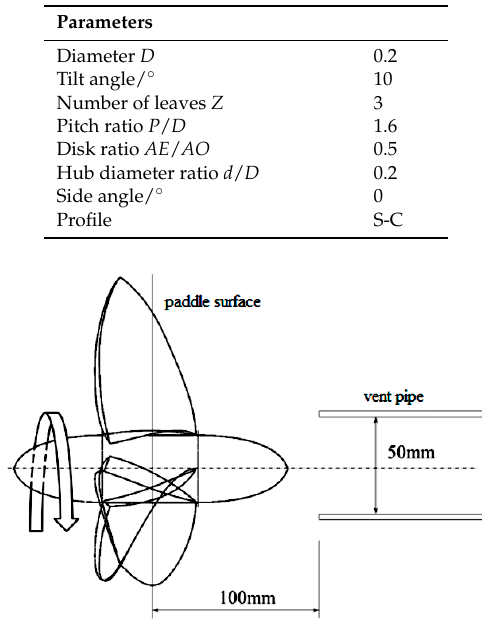
Table 1. SPP-1 propeller geometric parameters [6].